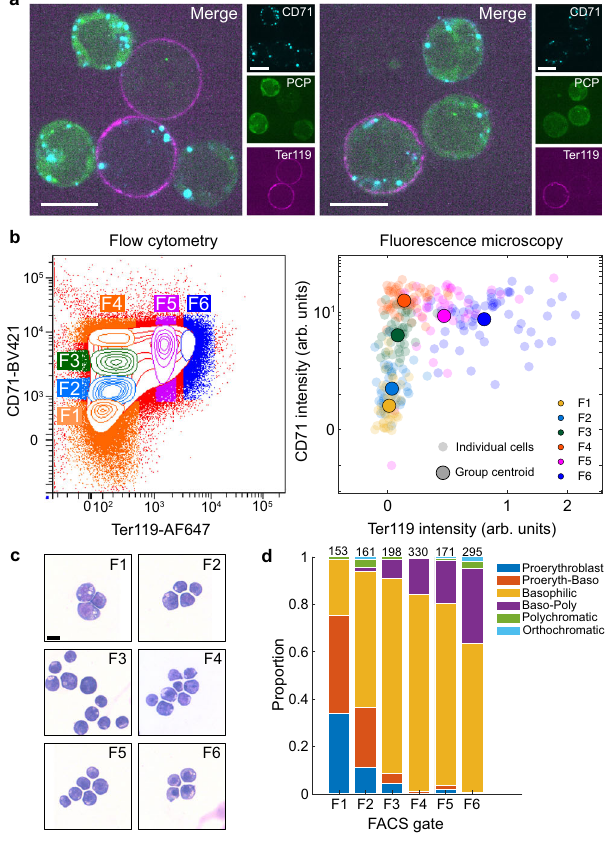
Fig. 3 | Live-cell antibody staining enables on-microscope staging of erythroid cells. a Example images of cells with variable levels of CD71 and Ter119 staining as well as PCP-EGFP. Single z-slices shown. Scale=10 μ m. Similar staining patterns were achievedfrom four independent experiments. b Day 7 EB-derived cells FACS- sorted (F1, F2, etc) according to CD71/Ter119 staining (left) and subsequently imagedonthemicroscope(right). c Representativeimagesofcellsfromthesorted populations in B stained with May-Grünwald-Giemsa solution. Scale=10 μ m. d Proportion of erythroblast stages in each FACS-sorted population scored by morphologyfromMGG-stainedcellsin c .Numbersindicatenumberofcellsscored. The results of this experiment were consistent with all previous staging studies using this protocol.